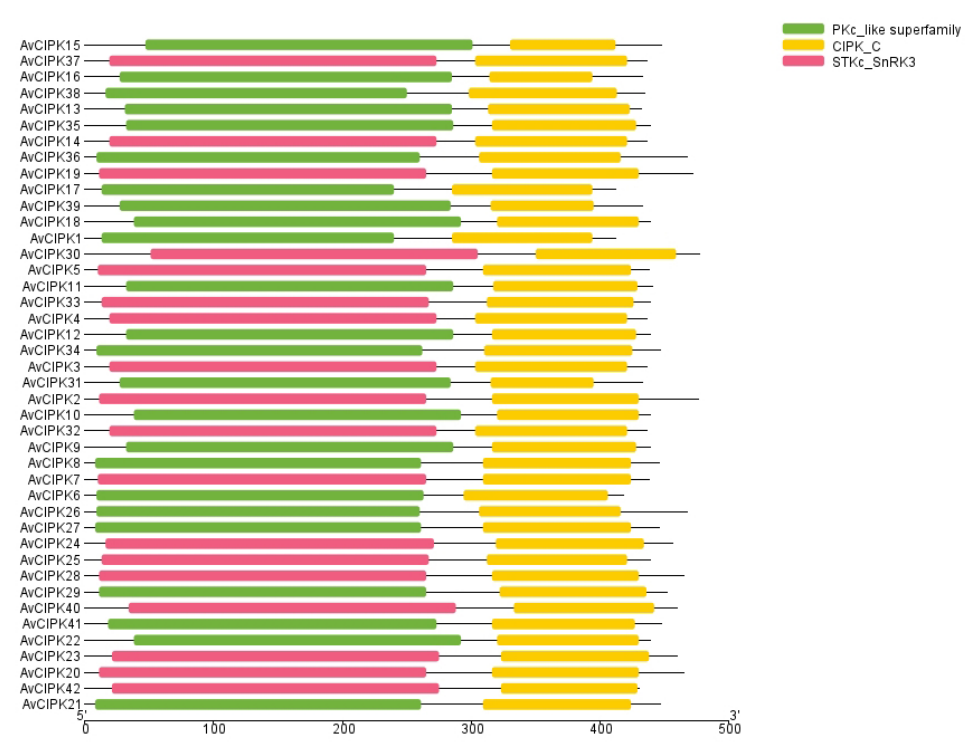
Figure 3. Identification of conserved domains in AvCIPK protein sequences.